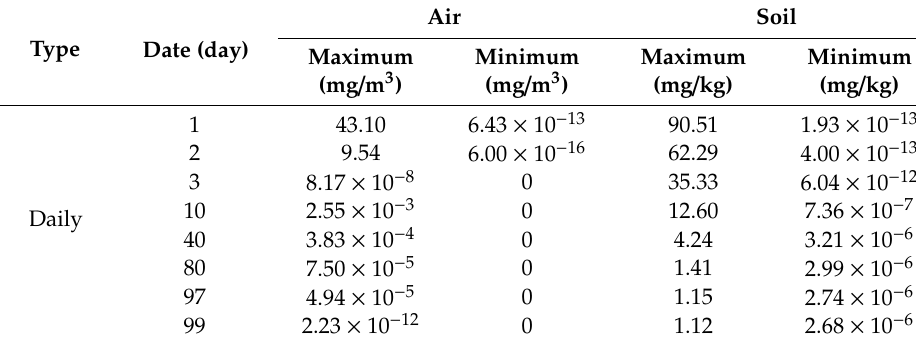
Figure 4. Long-term health risk assessment by age group. ECR: excess cancer risk. ( a ) 0–9 years of age; ( b ) 10–18 years of age; ( c ) 19–65 years of age; ( d ) 65 years of age and older. Table 5. Distribution of risk